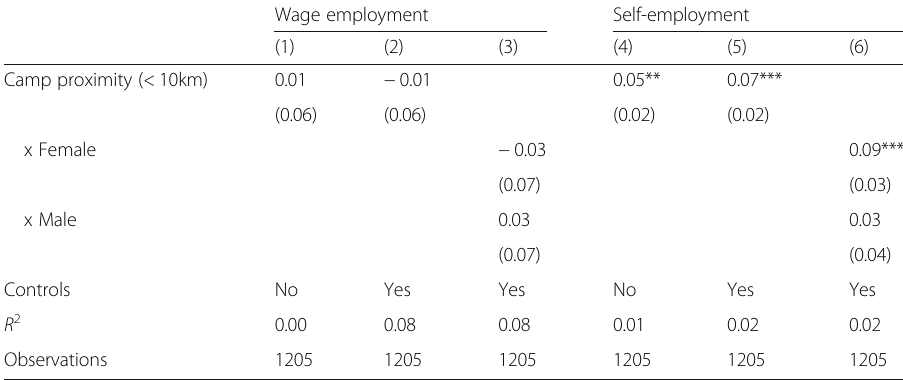
Table 7 Secondary activity of those engaged in farming/livestock production Wage employment Self-employment